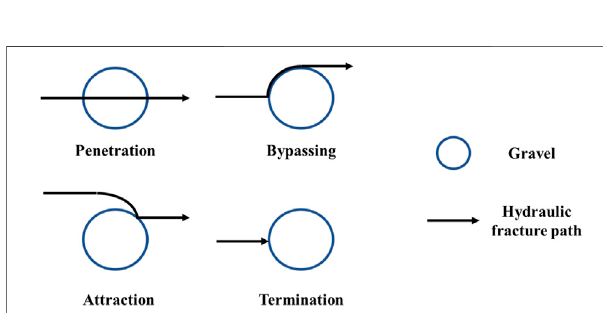
FIGURE 12 | Types of interactions between gravels and hydraulic fractures in tight sandy